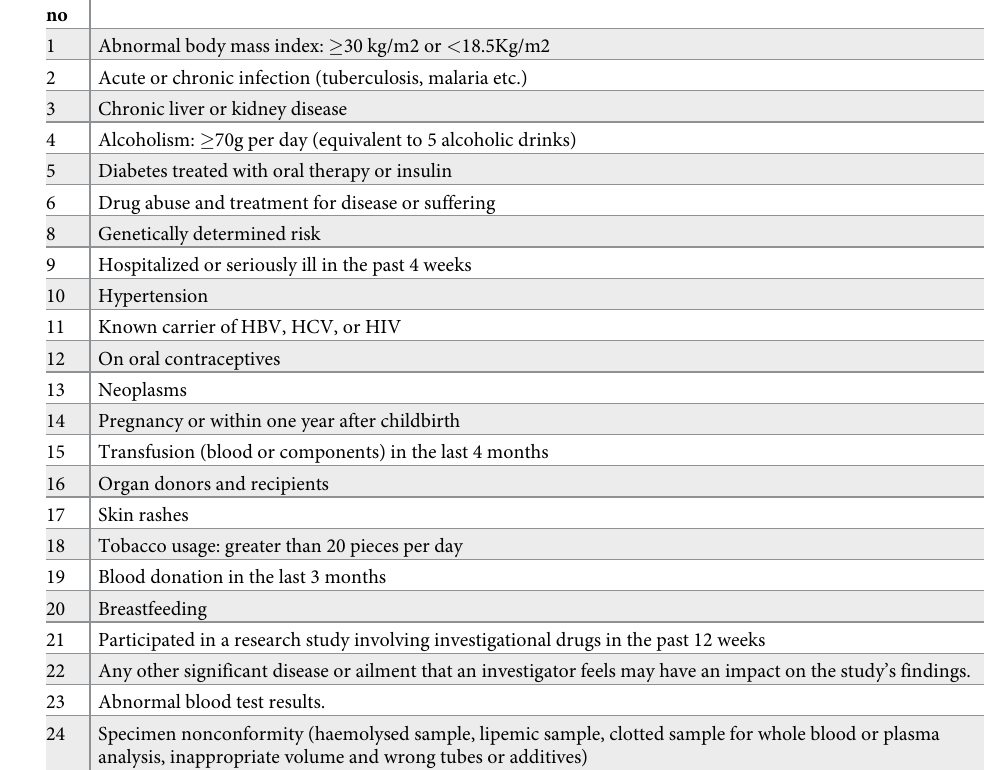
Table 1. Exclusion criteria. The participants and blood samples were excluded from the study if they met any of the following criteria. S.